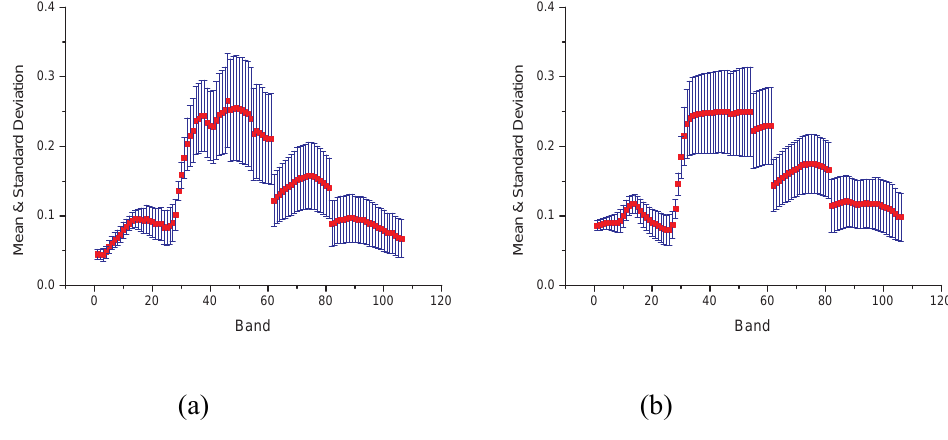
Figure 3 . Mean and standard deviation of 106 bands of original and simulated data: (a) shows the mean and standard deviation of original bands, and (b) shows the mean and standard deviation of simulated bands (for convenience in plotting, we used the sequence numbers 1–106 to refer to bands. The corresponding bands are listed in Table